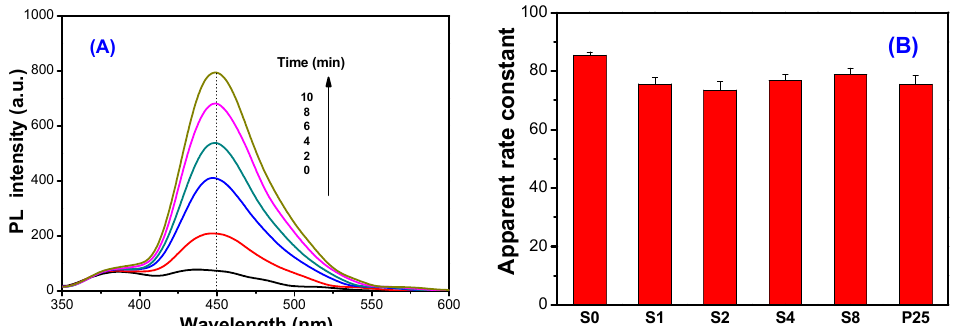
Figure 9. PL spectral changes ( A ) observed during irradiation of the R2 sample in 5.0 × 10 − 3 mol·L − 1 solution of coumarin (excitation at 332 nm) under UV irradiation, and the comparison of formation rate constant of hydroxyl radicals in the different photocatalyst ( B ).